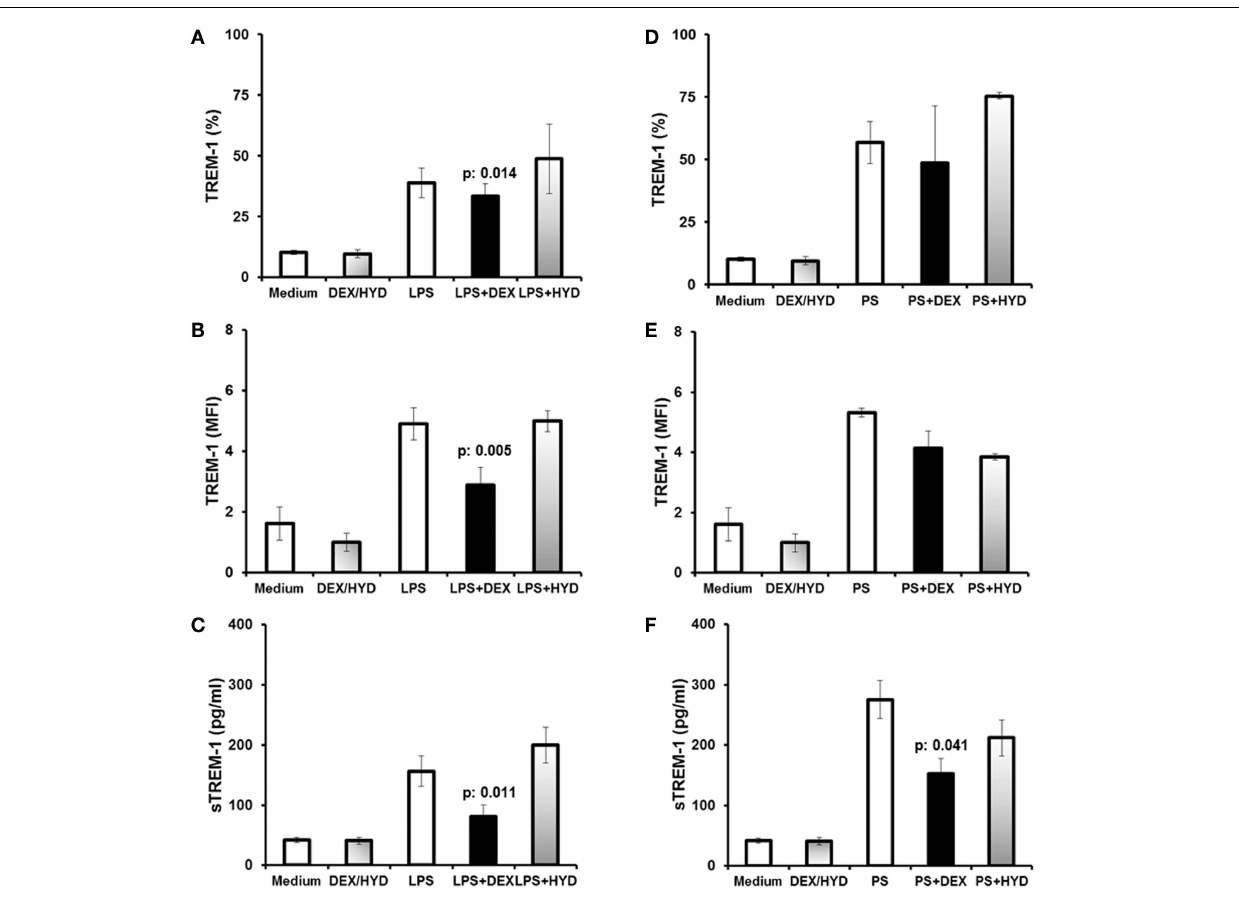
expression after stimulation with PS, and (F) shows sTREM-1 production after stimulation with PS. DEX/HYD represent unstimulated cells treated only with DEX or HYD, and the results are averaged. Data forTREM-1 are shown as percent of U937 cells expressingTREM-1 (A,D) , or asTREM-1 MFI for U937 cells (B,E) . Results from six experiments are shown. P values indicate significant differences compared to LPS or PS-treated